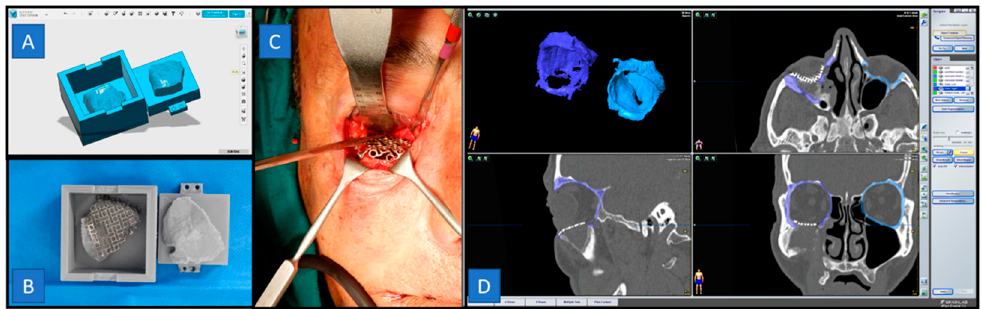
Figure 4. Virtual surgical planning (VSP) of the mesh-conformer ( A ), 3D printed mesh-conformer with the titanium mesh ( B ), intra-operative phase of the insertion of the pre-modeled mesh ( C ), and virtual check of the accuracy of the mesh using neuro-navigation software ( D ).